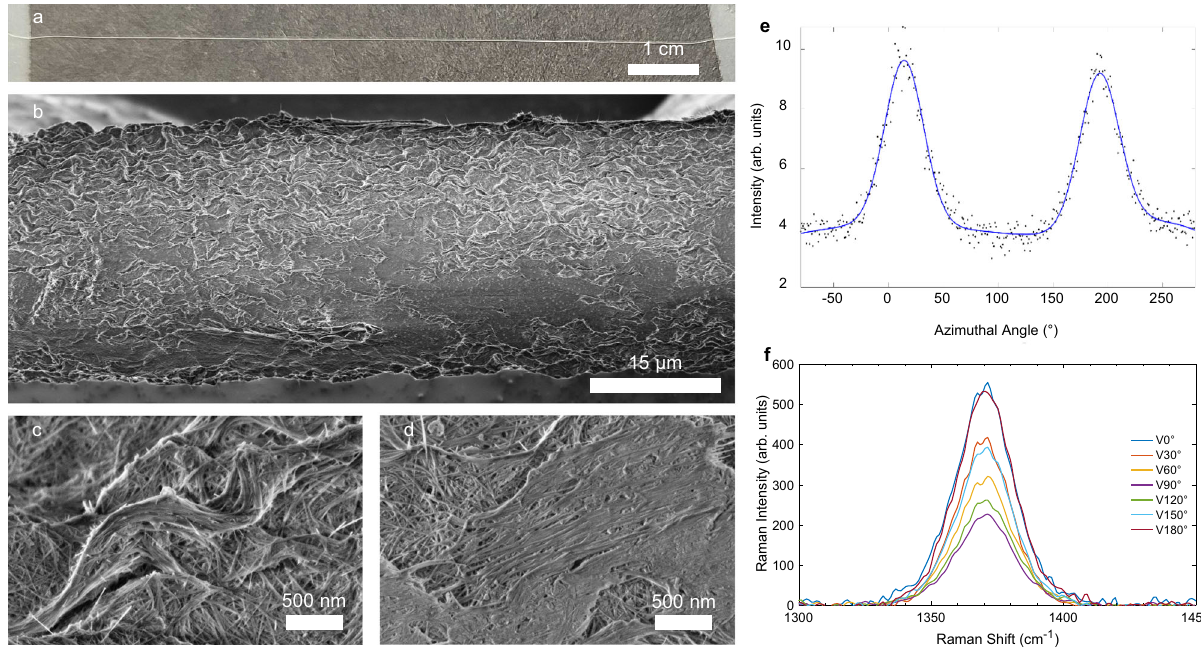
Fig. 4 Solution-spun fi bers of BNNTs. a Photograph of typical segment of fi ber made from highly puri fi ed BNNTs taped to a benchtop under tension. b Scanning electron microscopy (SEM) showing a 27 μ m diameter fi ber with wrinkled and smooth areas of the fi ber skin. c SEM showing mild alignment of BNNTs along the wrinkle contours. d SEM of a smooth area of the fi ber surface showing strong BNNT alignment along the fi ber axis. e Wide-angle X-ray scattering of BNNT fi ber (black dots) plotted against azimuthal angle shows two peaks from the fi ber fi t with a Gaussian curve (blue line) with full-width at half maximum (FWHM) of 42°. f Raman spectra of BNNT fi ber with V0°, V30°, V60°, V90°, V120°, V150°, and V180° polarizer/analyzer modes. Laser excitation was given by a 785 nm laser. A sharp peak at ∼ 1370 cm − 1 is characteristic of